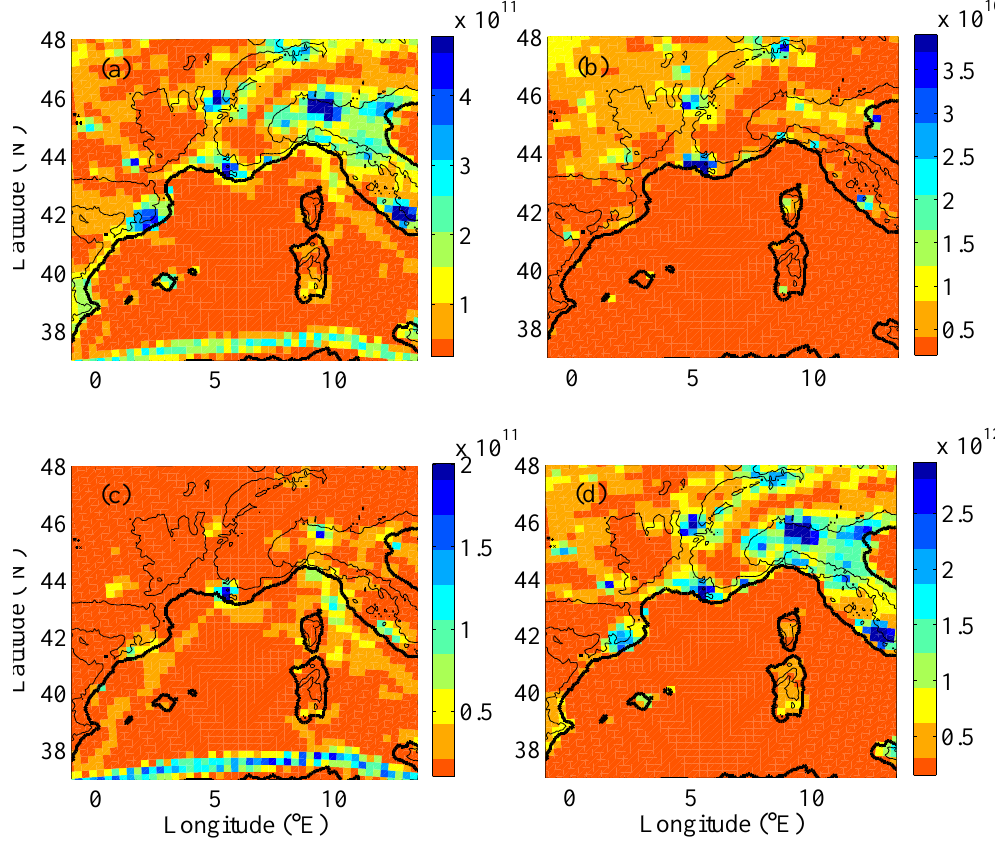
Fig. 7. EMEP inventory emissions in Mg/(50km × 50km)/year, adjusted on the grid of the domain 3 at 12:00UTC. Panels (a) , (b) , (c) and (d) represent the concentrations of NO (a), PPM coarse particles ( ≥ 2.5 µ m and ≤ 10 µ m) (b), SO 2 (c) and CO (d) during a labor day of March 1998.